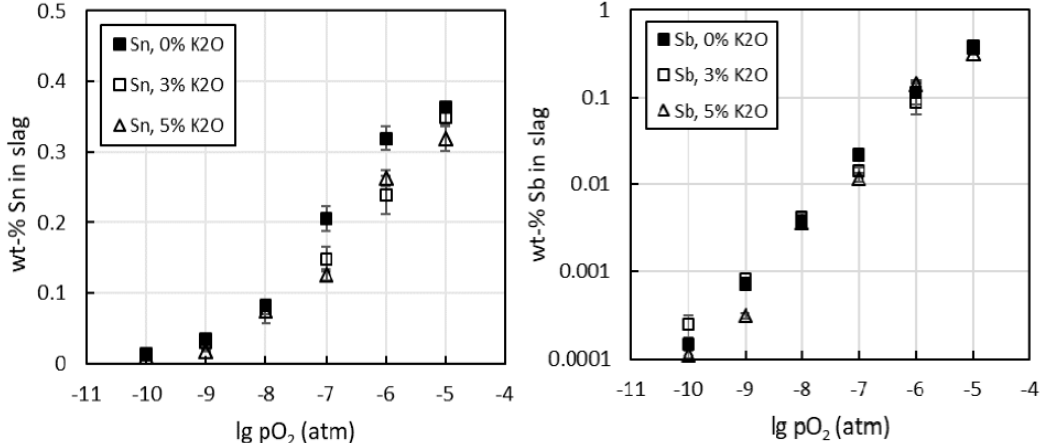
Figure 6. Left side: concentration of tin in liquid slag phase. Right side: concentration of antimony in slags as a function of oxygen partial pressure. For tin, LA-ICP-MS results were used for oxygen partial pressures below 10 − 8 atm, and for antimony below 10 − 6 atm. The concentration of antimony is plotted in logarithmic scale in order show more accurately the low concentrations in reducing conditions.